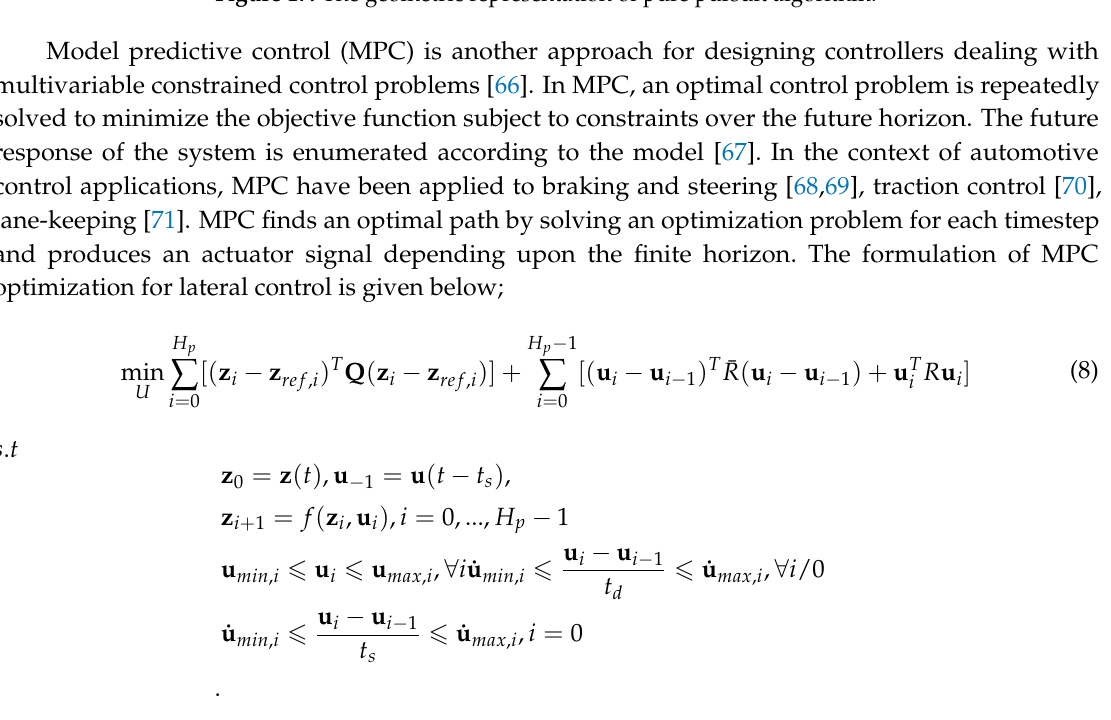
Figure 17. The geometric representation of pure pursuit